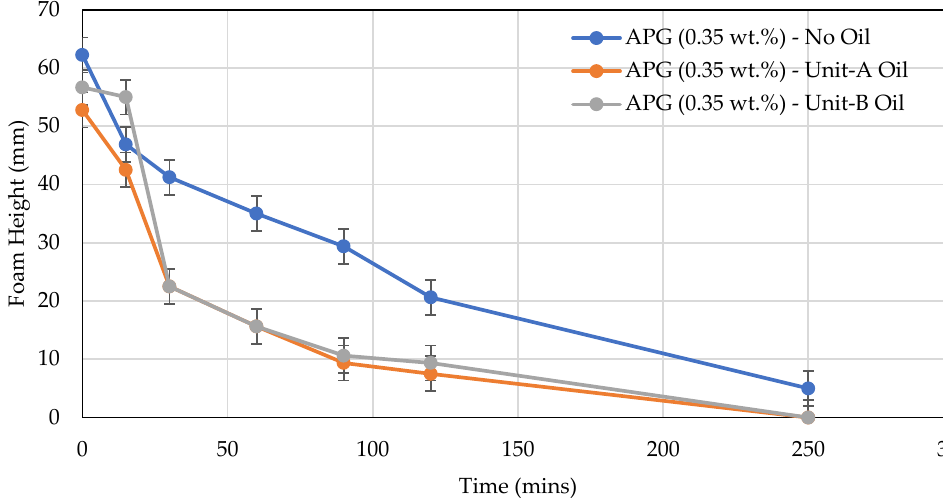
Figure 5. Bulk foam height (mm) as a function of time (minutes) without and with crude oils from Unit-A and Unit-B.